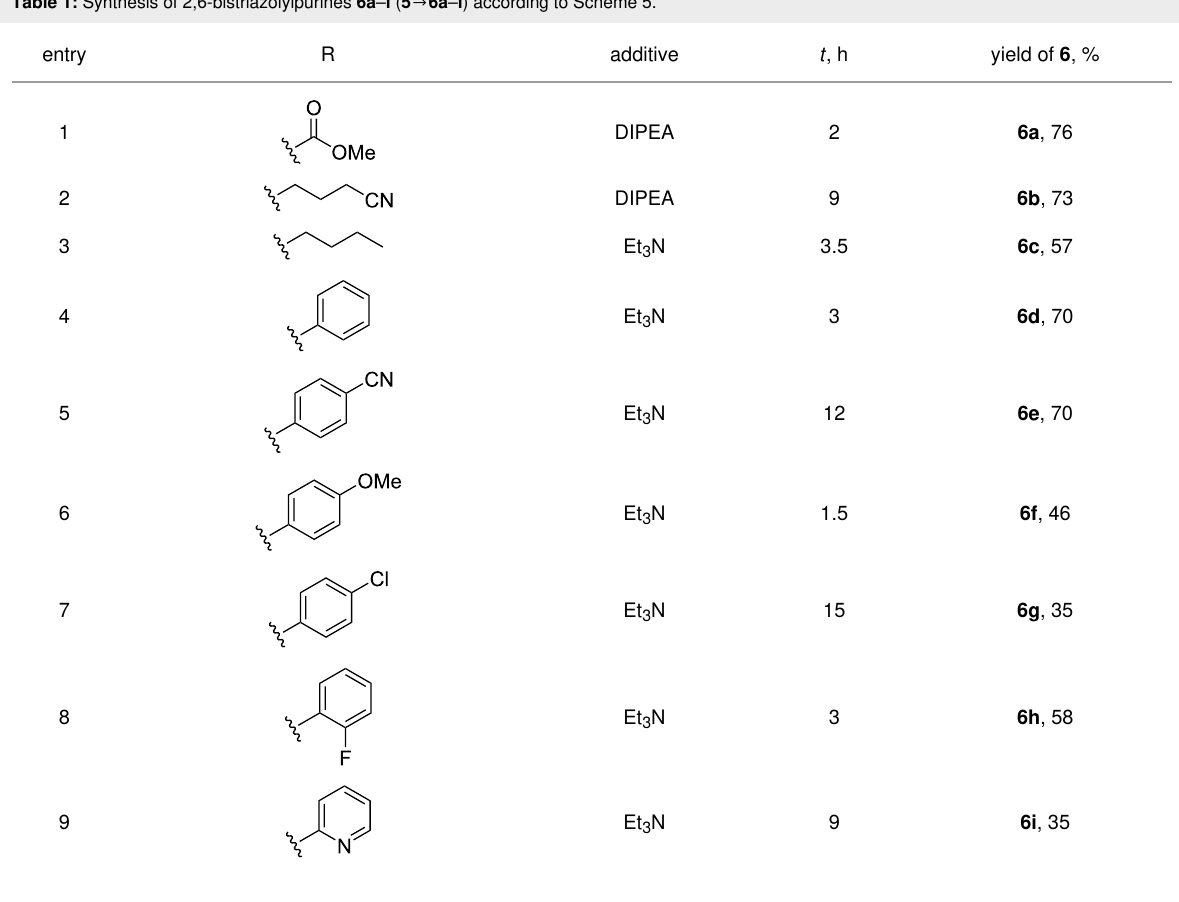
Table 1: Synthesis of 2,6-bistriazolylpurines 6a – i ( 5 → 6a – i ) according to Scheme